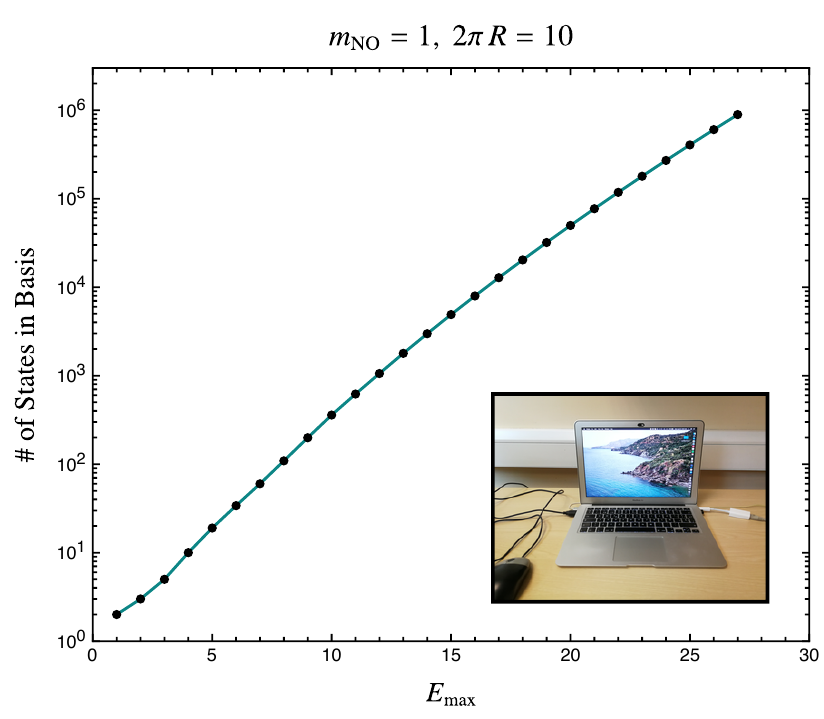
Fig. 1. Number of states in the basis for the H matrix computed on a laptop [ inset ] in this work. The highest point in the plot corresponds to E